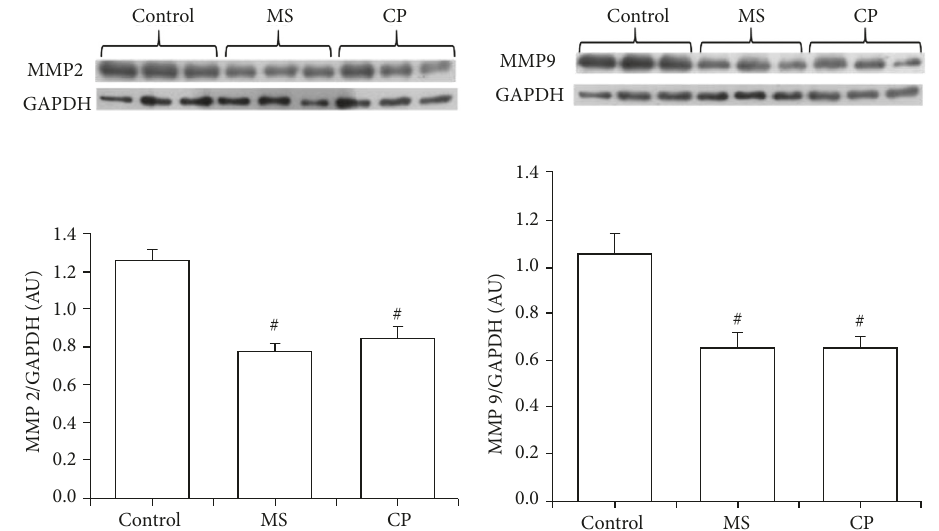
Figure 4: Expression of metalloproteinases 2 and 9 in aortas from control, MS, and CP rats. There is a decrease in their expression in both groups. MS rats ingested sucrose solution during six months; CP animals ingested sucrose solution during postnatal days 12 to 28. Control rats received tap water. A representative blot is shown above the graphics. Values are means ± SEM; # P ≤ 0 . 05; n � 8.